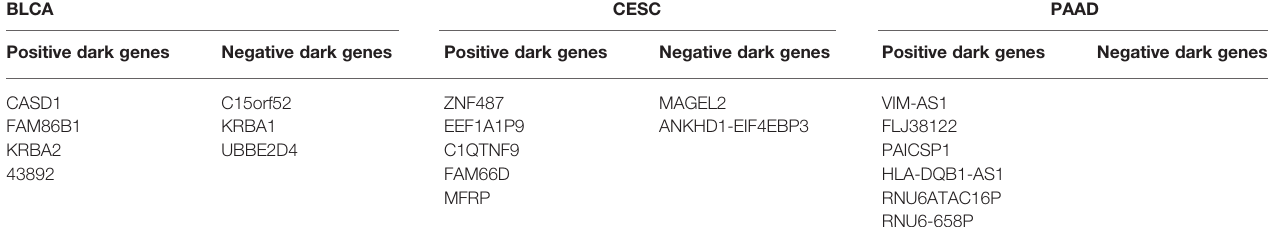
TABLE 4 | ‘ Dark genes ’ representing positive and negative biomarkers for BLCA, CESC and PAAD disease